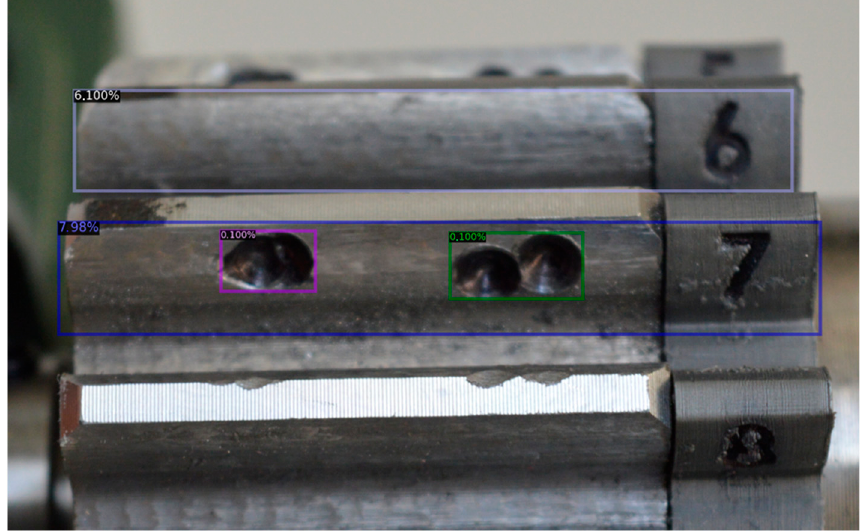
Figure 4. Output image of the gear with middle pitting damage.